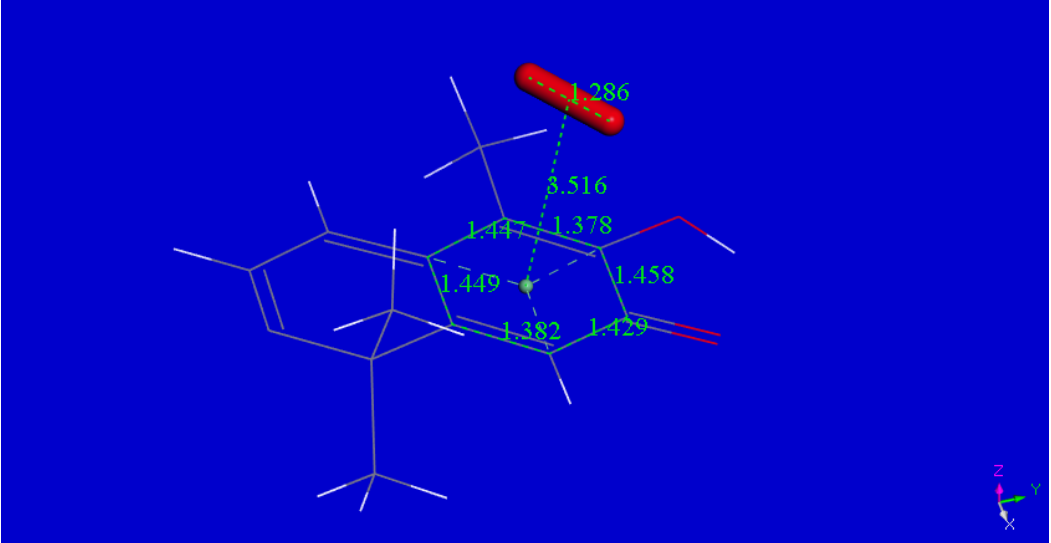
Figure 9. Superoxide π-π approached by model celastrol, final state, obtained after density functional theory (DFT) geometry optimization. Comparing with Figure 8, there is lengthening of the ring C-C double bonds, 1.382 Å and 1.378 Å, and shortening of O-O bond, 1.286, due to O 2 formation. Additional examination of the celastrol antioxidant action through its ring E carboxylic moiety is now